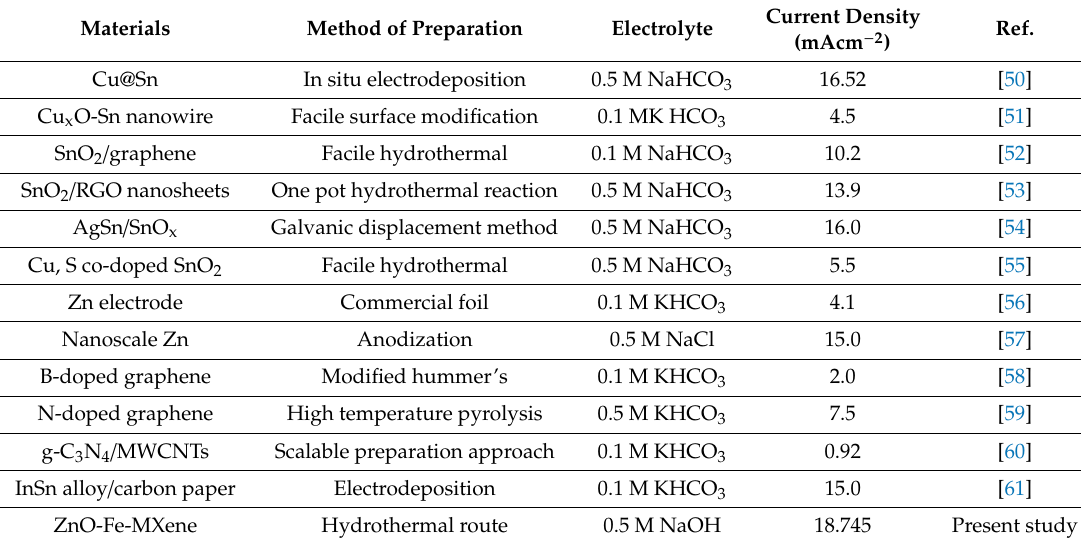
Table 3. Comparison of the electrochemical reducing (eCR) performance of various 2D metal oxide based catalysts.